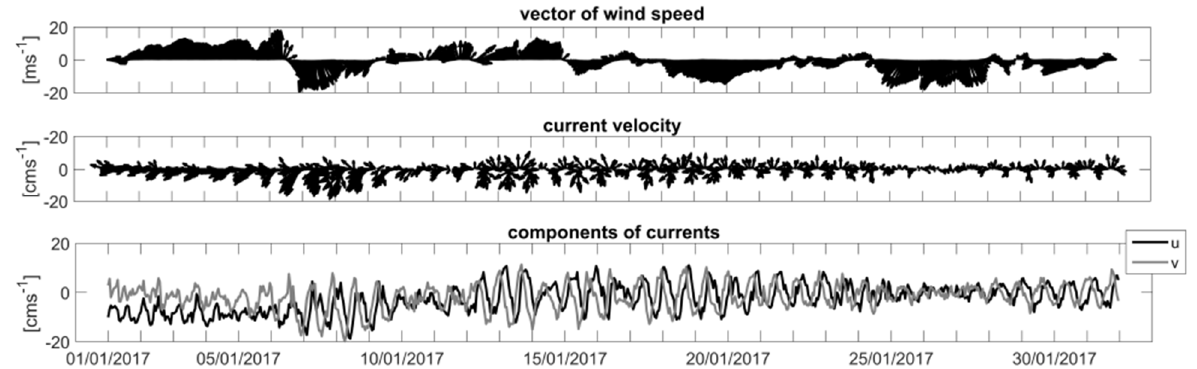
Figure A1. Top—wind speed 𝐔(𝑡) vector plot from the ERA-5 meteorological reanalysis data. The second plot from the top is the current velocity 𝐮(𝑡) at 100 m at ABS No. 1 in January 2017, and the third plot from the top shows the 𝑢 - and 𝑣 -components of the current velocity.